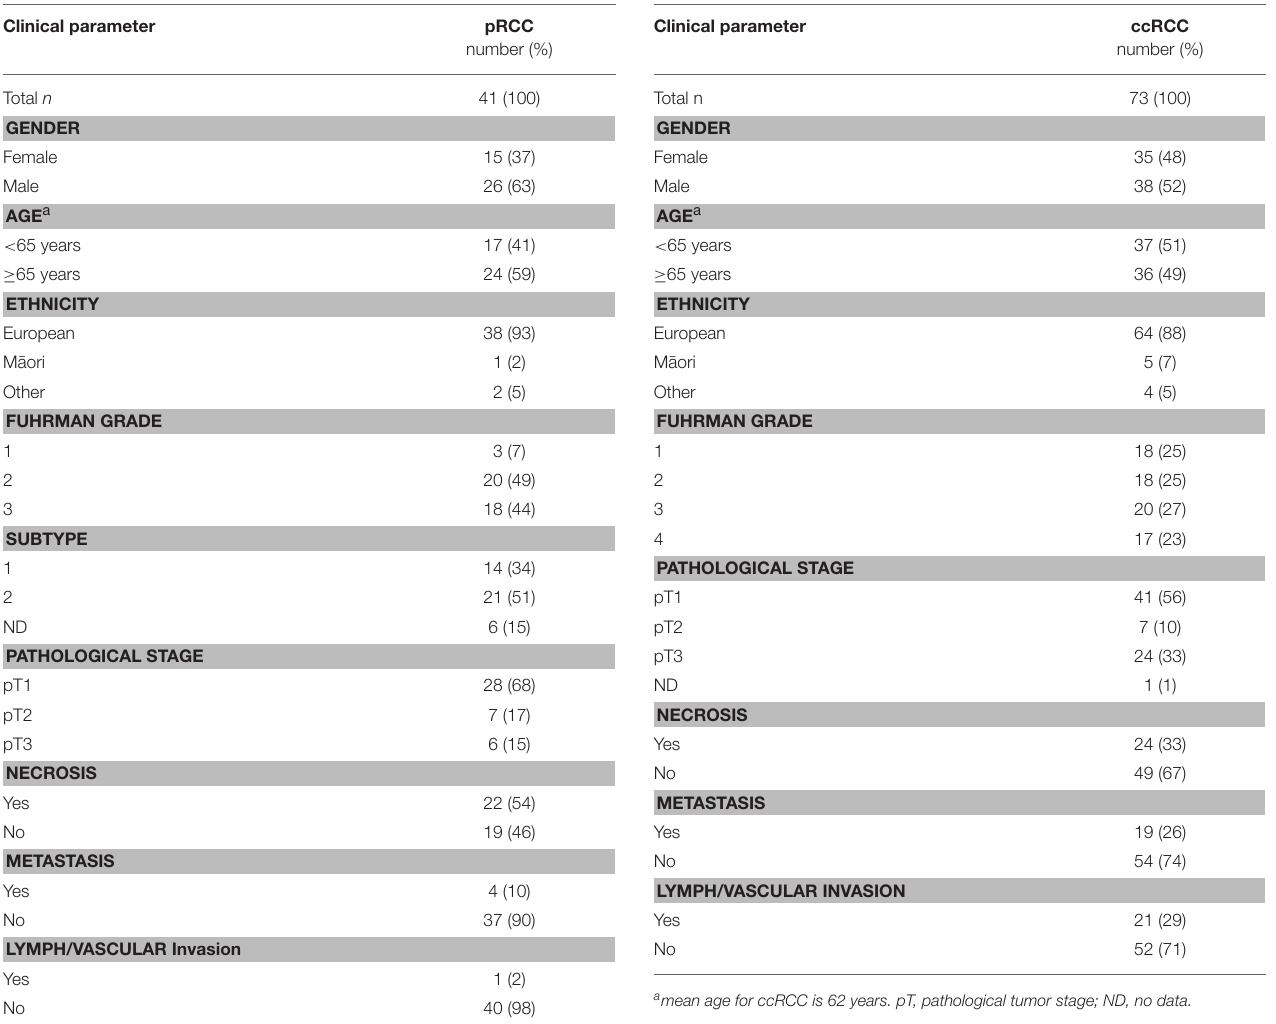
TABLE 2 | Patient demographics and tumor characteristics for clear cell RCC. Clinical